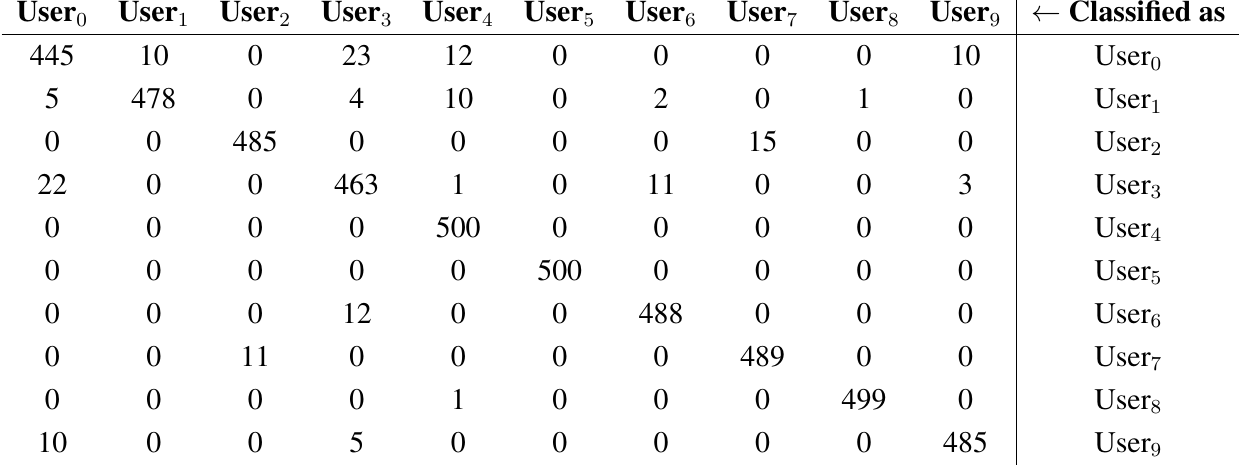
Table 8. Aggregate confusion matrix for multilayer perceptron based on 10 times 10-fold cross-validation for 10 subjects’ walking